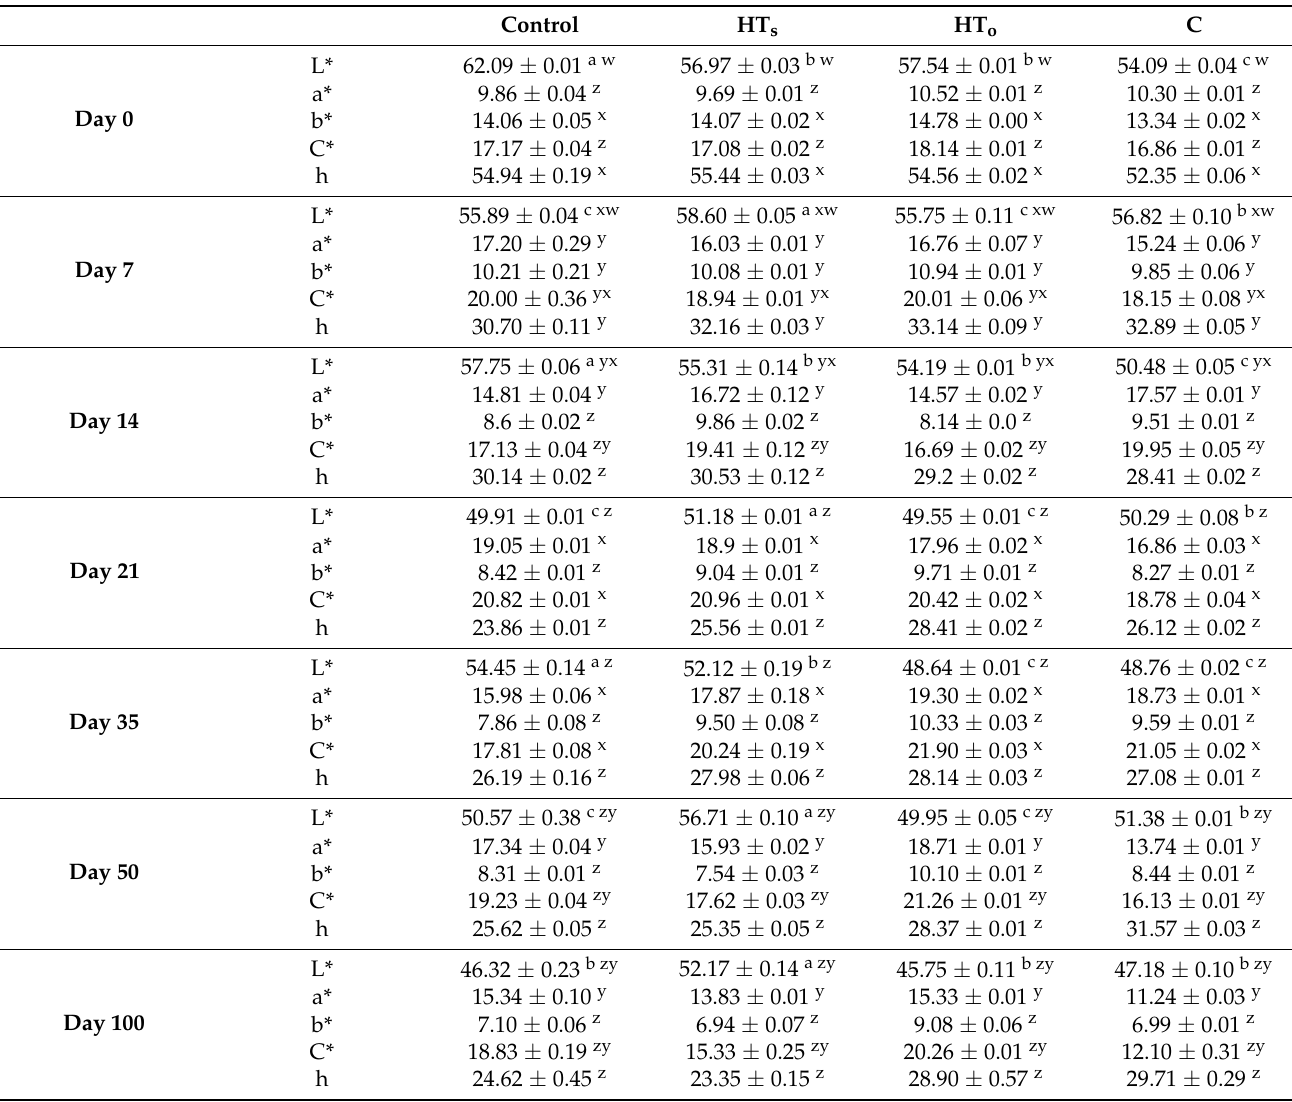
Table 4. Color development during ripening and refrigerated storage of fuet